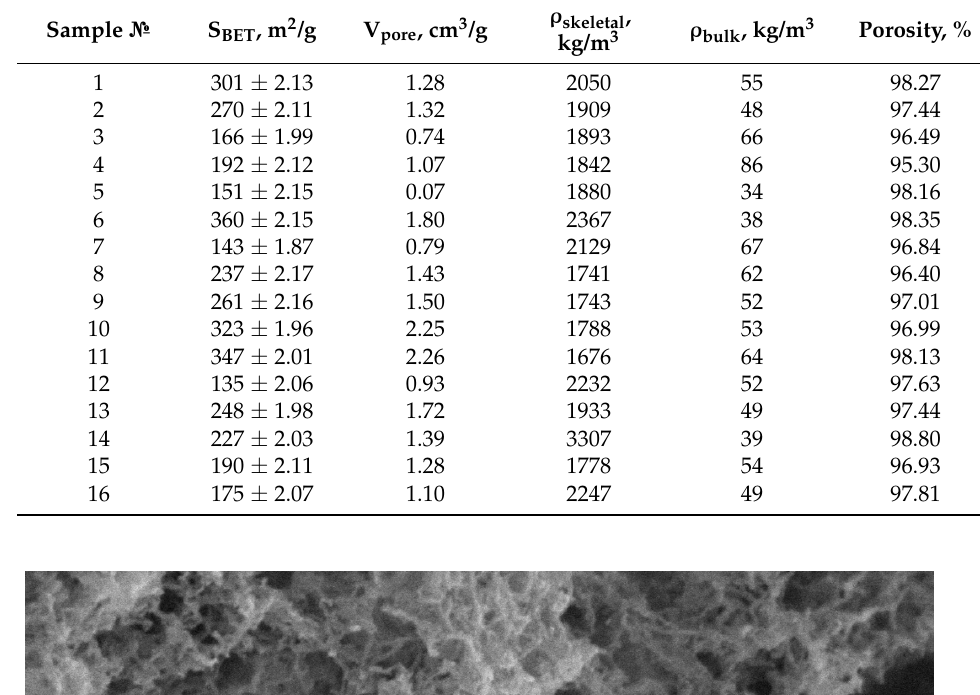
Table 2. Analitical studies result of the chitosan-based aerogel particles samples.